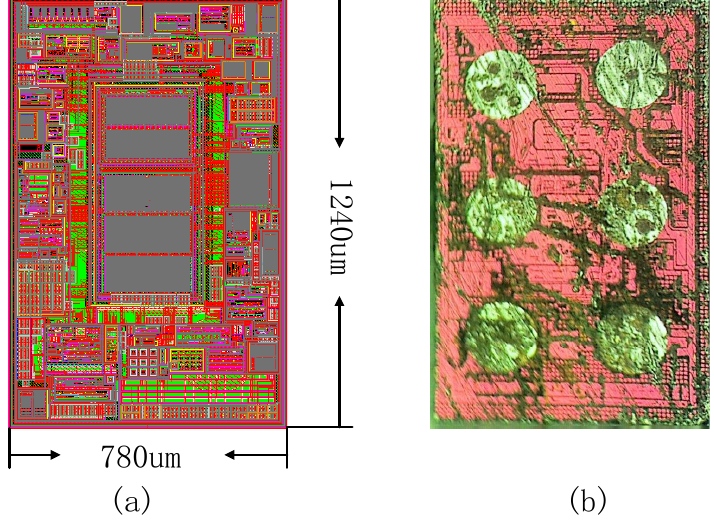
Figure 12. Layout design image and micrograph of the proposed boost converter. ( a ) Layout design image of the proposed boost converter. ( b ) Micrograph of the proposed boost converter.